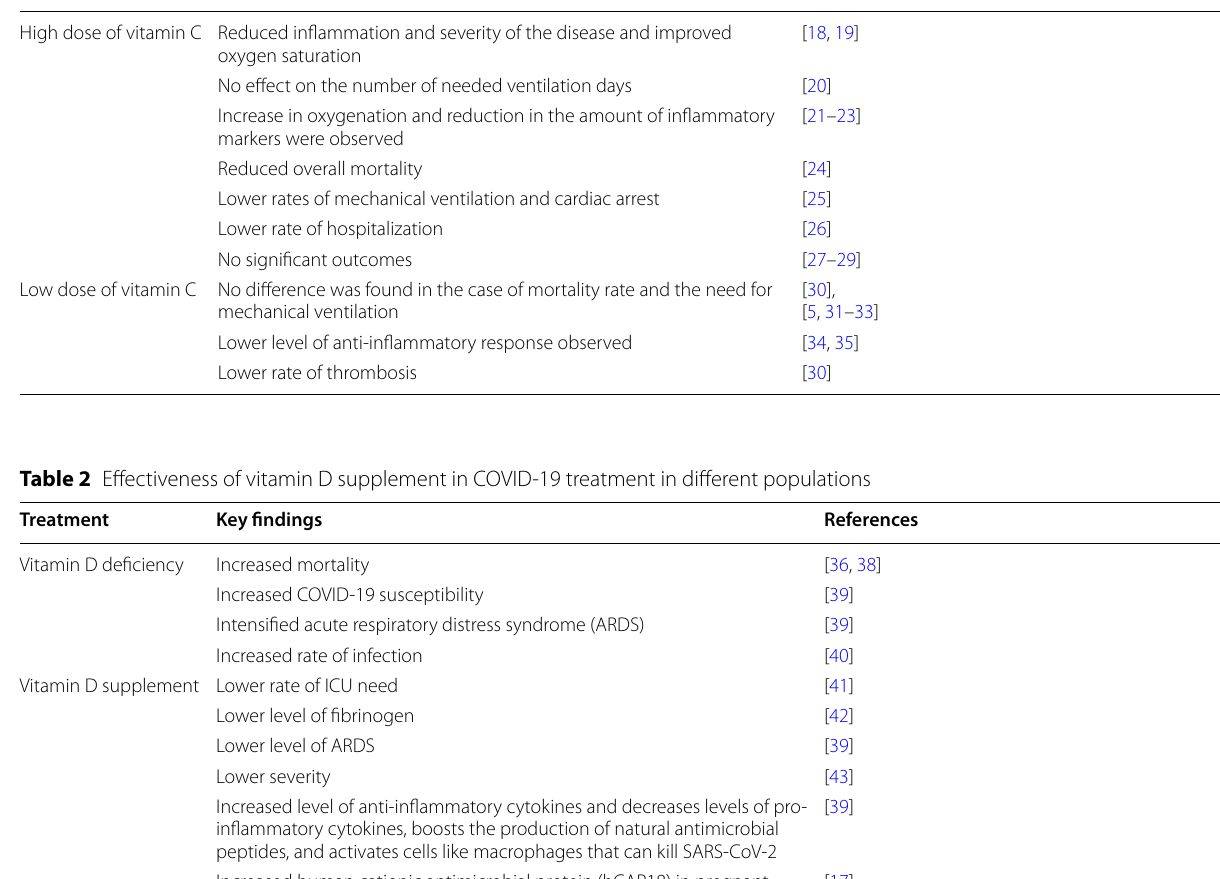
Table 1 Effectiveness of vitamin C supplement in COVID-19 treatment in different populations Treatment Key findings